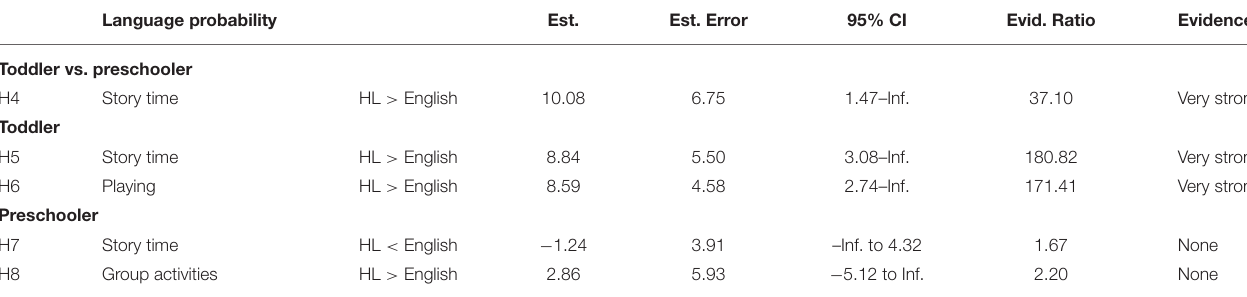
TABLE 6 | Results from the hypothesis tests for educator output per selected activities. Language probability Est. Est. Error Evid.